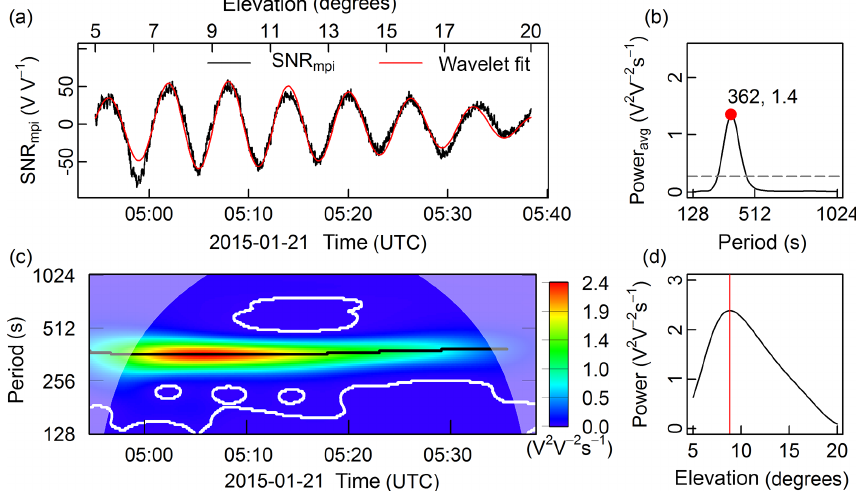
Figure 1. Example of a usable GPS01 ascending track SNR data set from 04:50 to 05:38UTC on 21 January 2015: (a) multipath SNR data (in VV − 1 ), (b) average power spectrum with its maximum value (red dot) and (c) power spectrum for periods from 128 to 1024s. The red line in (a) is the reconstructed SNR data by the daughter wavelet corresponding to the peak period (362s) indicated in (b) . The power at the peak period across elevation angles (d) presents a maximum value at an elevation angle of about 9 ◦